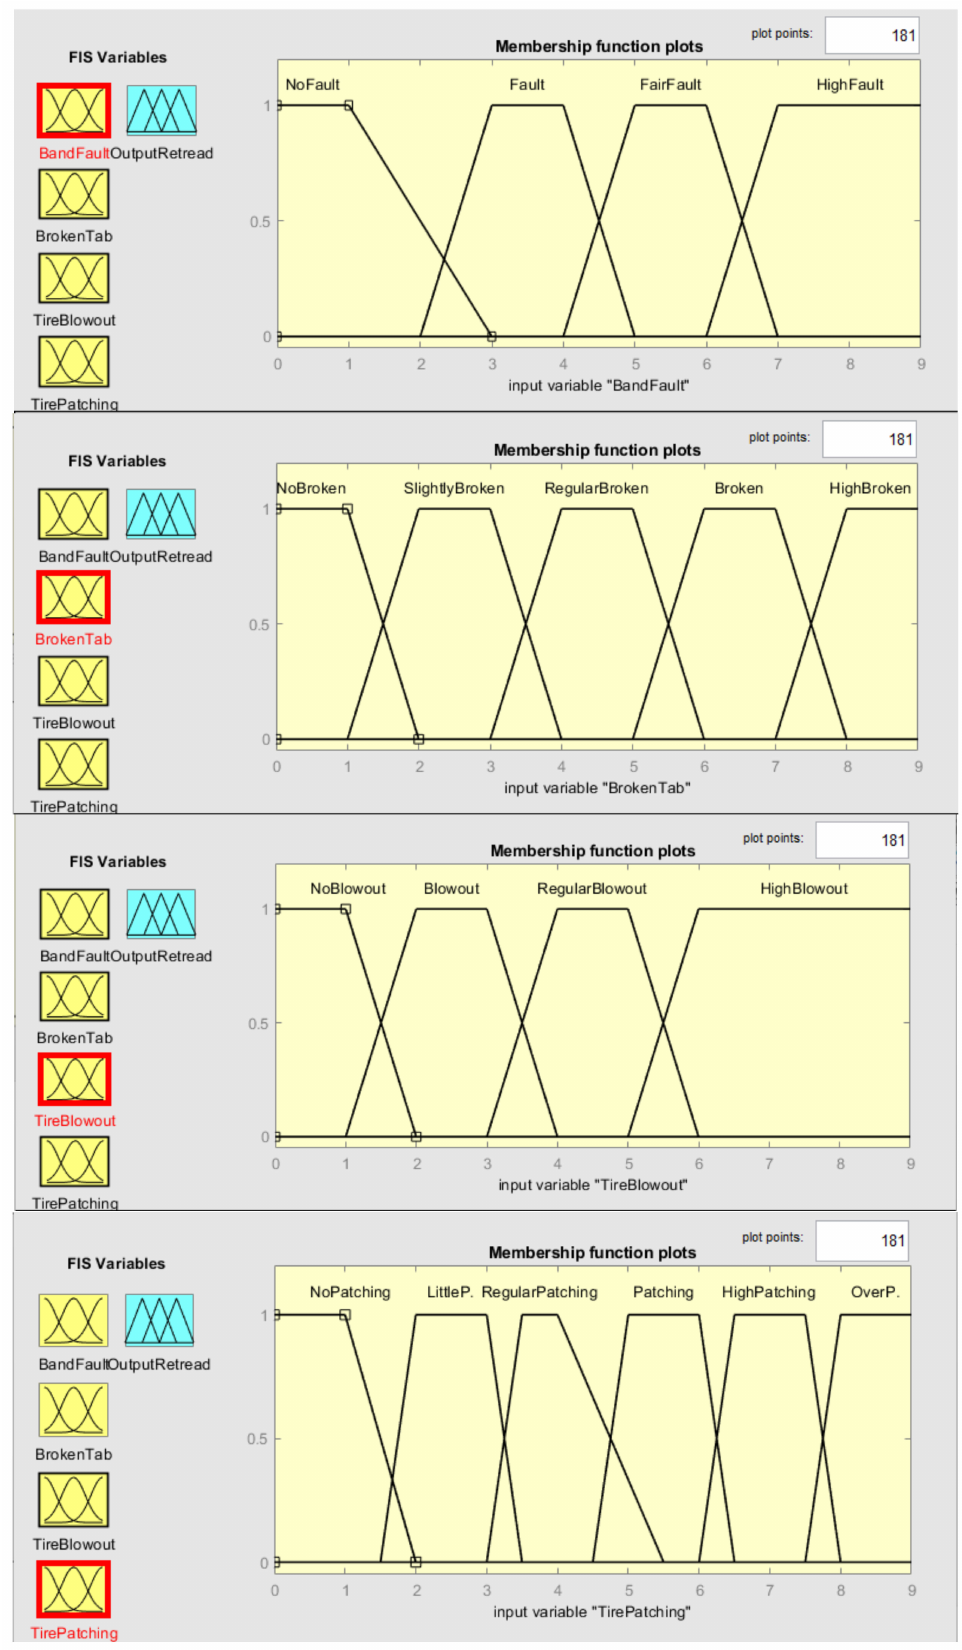
Figure 5. Trapezoidal Membership Functions of input